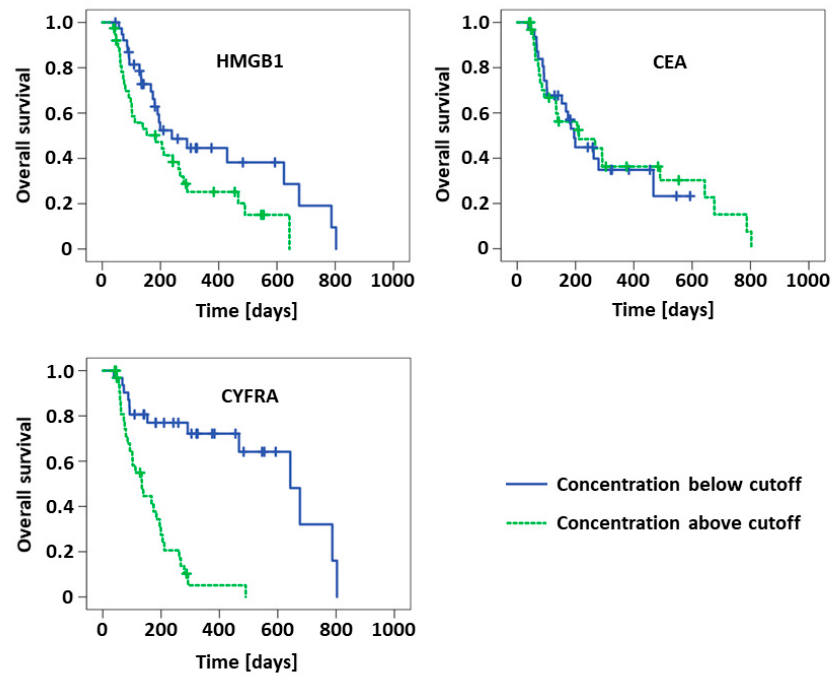
Figure 3. Kaplan–Meier curves of NSCLC patients possessing concentrations of HMGB1, CEA and CYFRA below or above the respective cutoff values at the second chemotherapy cycle.